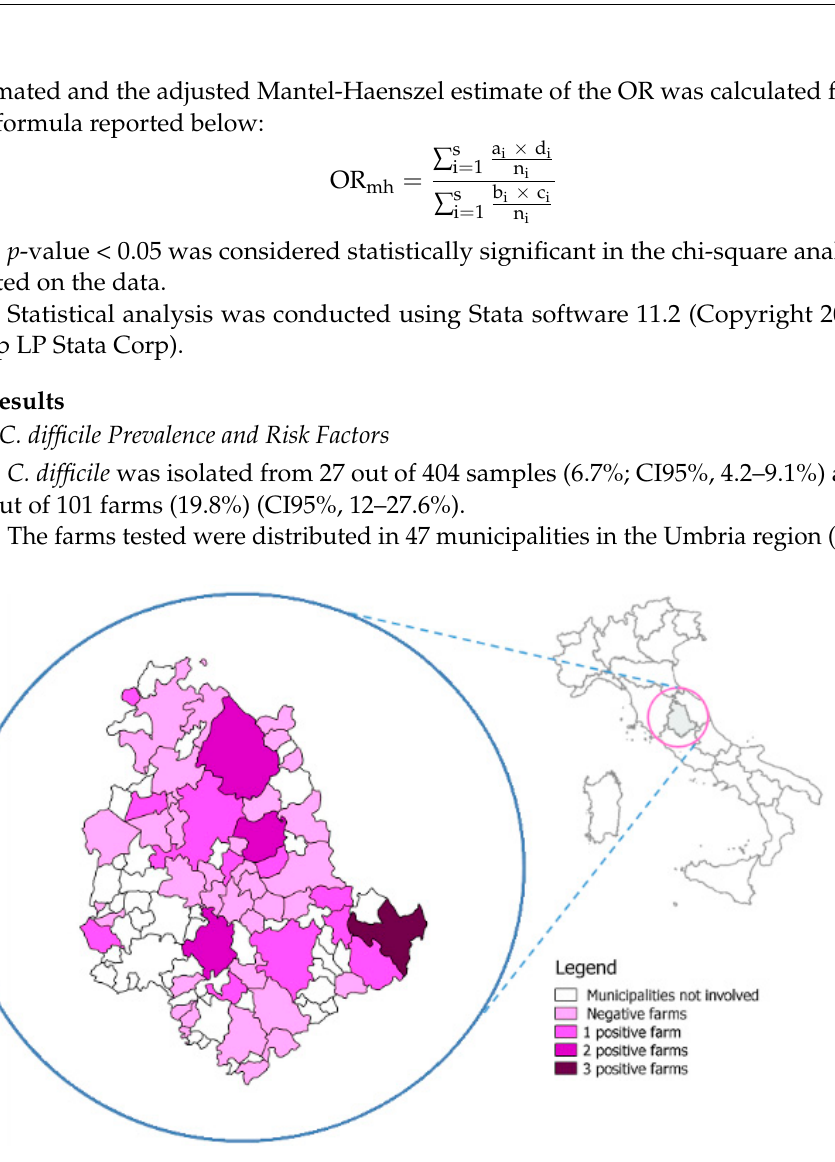
Figure 1. Geographical distribution of C. difficile positive farms.